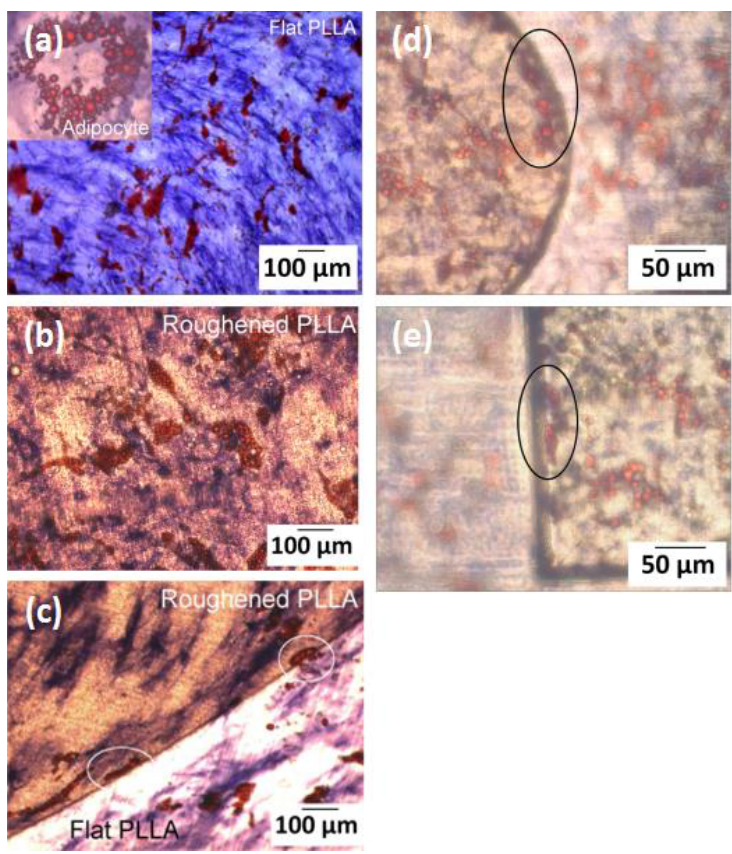
Figure 9. Bright field (BF) images of MSCs differentiated into adipocytes (presence of lipid vacuoles in red) and osteoblasts (AP staining in blue) on FLAT PLLA; ( a ), ROUGH PLLA; ( b , c ), and in microcavities ( d , e ). In ( c )–( e ), strings of lipid vacuoles following the walls of the microcavities are outlined by white and black ovals, respectively.